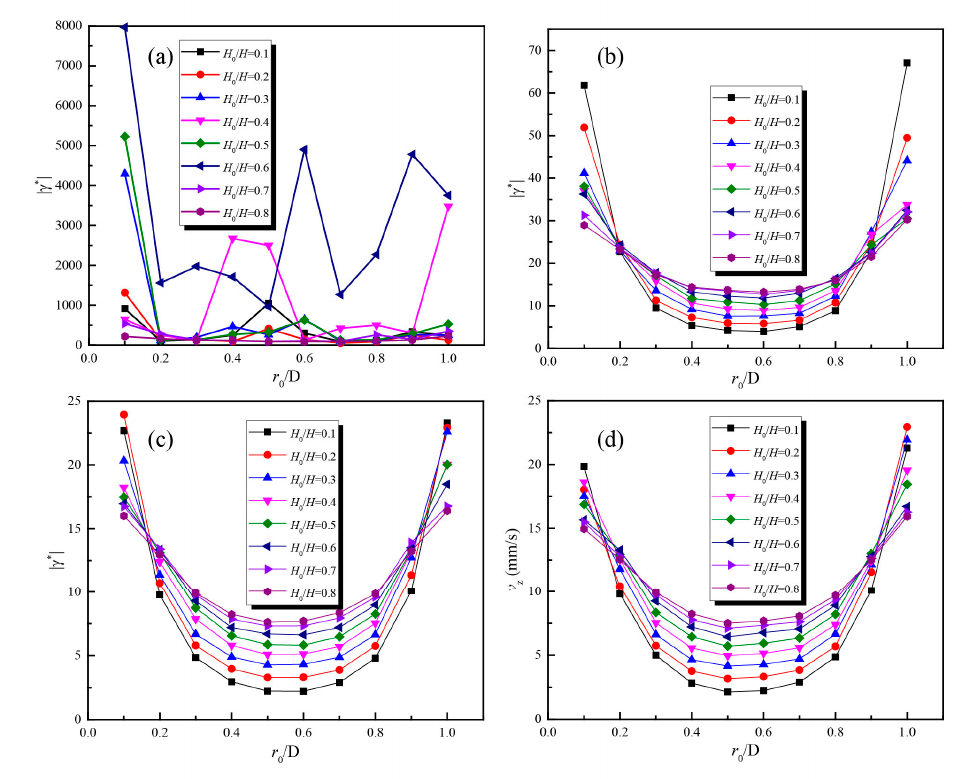
Figure 15. The variation in shear rate in sinter layers with different normalized outlet scales of ( a ) d 0 / D 0 = 0.1, ( b ) d 0 / D 0 = 0.2, ( c ) d 0 / D 0 = 0.3, and ( d ) d 0 / D 0 = 0.4.